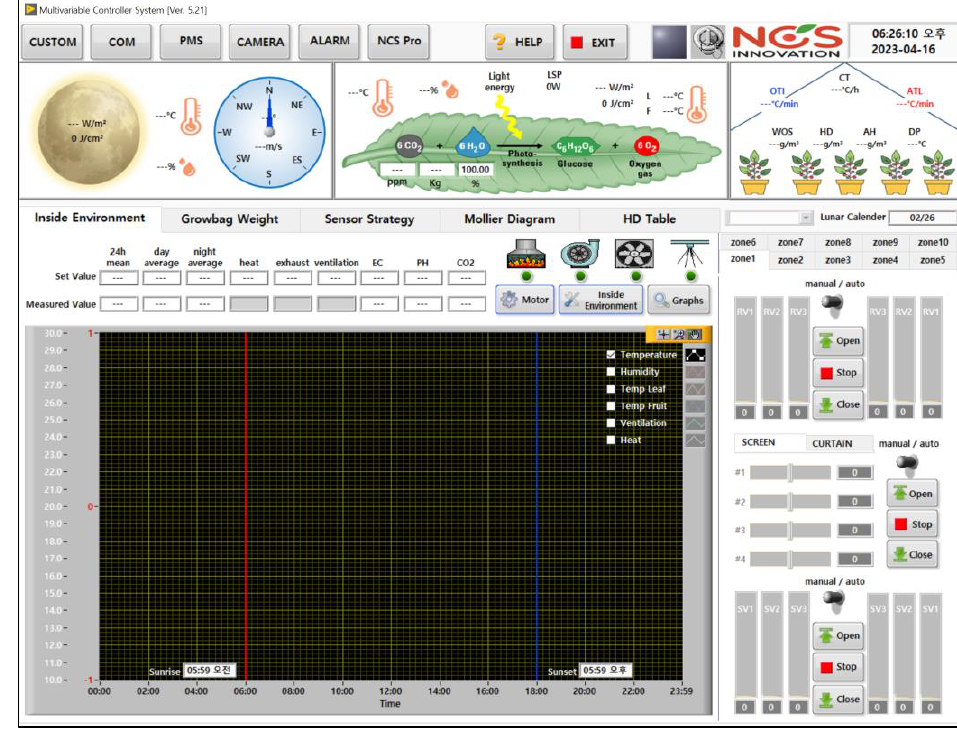
Figure A2. The main software user interface.